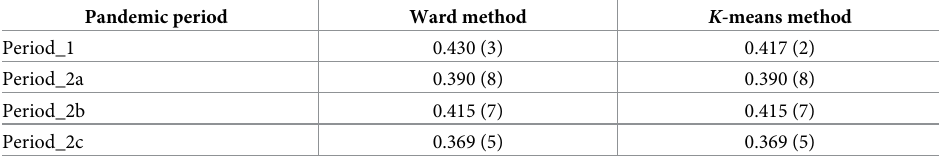
Table 6. Silhouette coefficients for all six